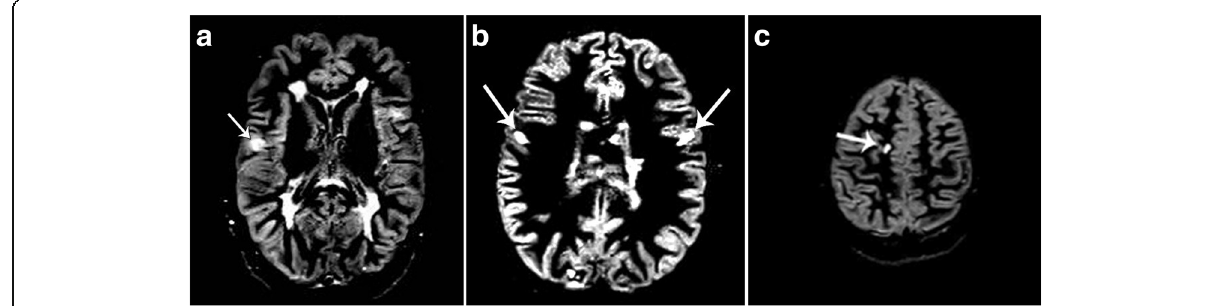
Fig. 1 Axial DIR images showing cortical lesions location: a Intracortical lesion in the right temporal region. b Two leukocortical lesions in the right and left frontoparietal regions. c Juxtacortical lesions in the right prefrontal regions